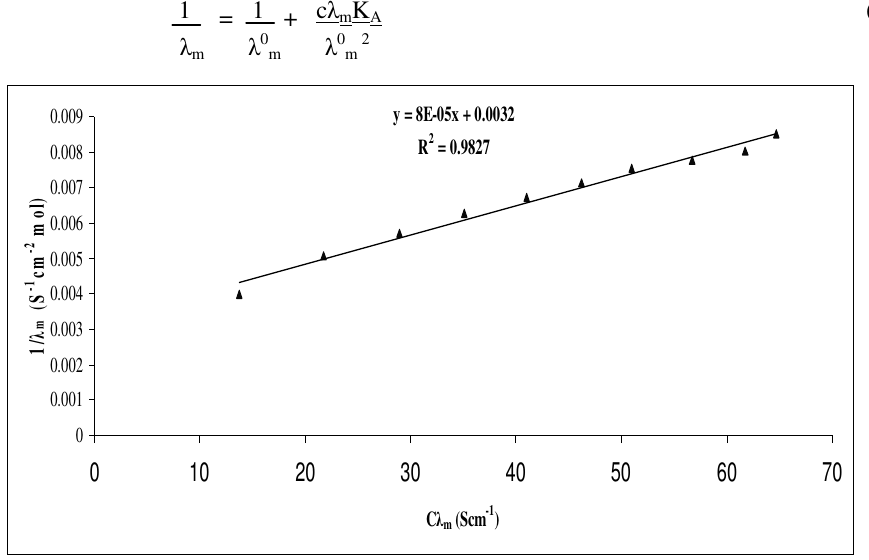
Figure 5. Plot c (cid:1) m versus 1/ (cid:1)